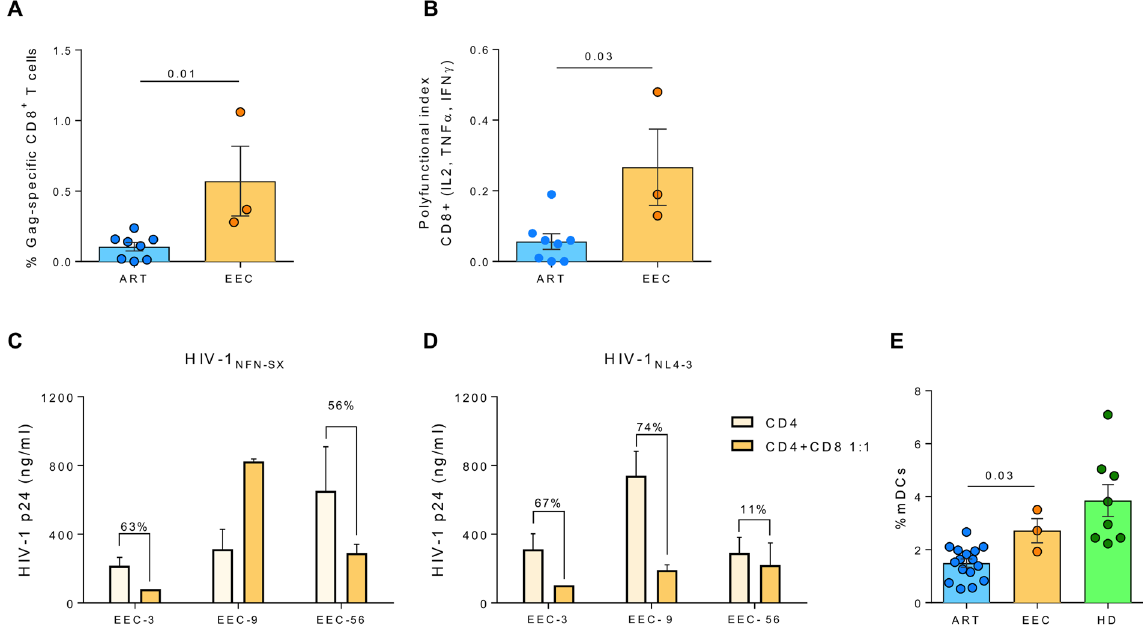
Figure 3. Cellular Immune responses. ( A ) Total CD8 + T-cell Gag-specific response from EEC and HIV- 1-infected individuals on suppressive ART. ( B ) INDEX of polyfuncionality (pINDEX) of Gag-specific total CD8 + T-cells from EEC and HIV-1-infected individuals on suppressive ART based on the proportions of cells producing intracellular combinations of IFN- γ , TNF- α , IL-2. ( C , D ) Viral inhibition assay. Assay of the ex vivo ability of CD8 + T cells to inhibit superinfected autologous CD4 + T cells of the three individuals. The figure shows day 7 of an infection with a laboratory viral strain ( C ) HIV-1 NFN-NX (CRR5-tropic) and ( D ) HIV-1 NL4–3 (CXCR4-tropic). Percentage of inhibition of CD4 + vs CD4 + :CD8 + T cells is indicated in each individual. ( E ) Total myeloid dendritic cell quantification, comparing EEC with HIV-1-infected individuals on ART and non- HIV-1-infected healthy donors (HD). ( A , B and E ) Differences between groups were determined by Mann- Whitney U